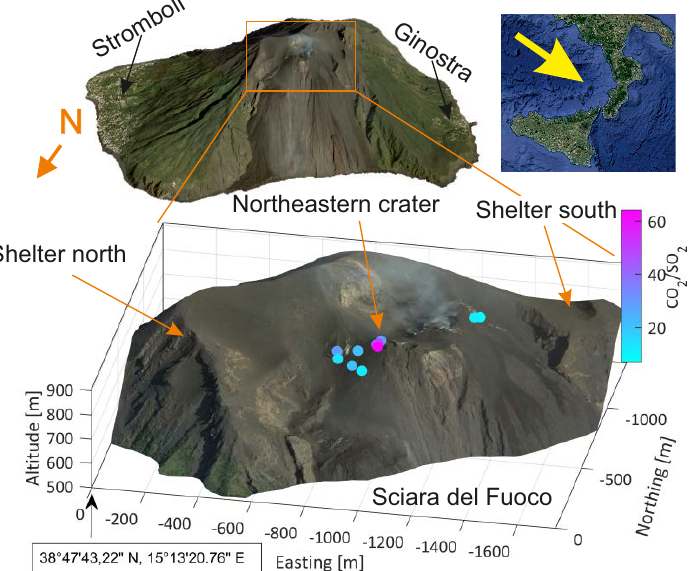
Figure 1. Overview of the sampling site at Stromboli volcano with the locations of the retrieved CO 2 / SO 2 mixing ratios given in Table 2.